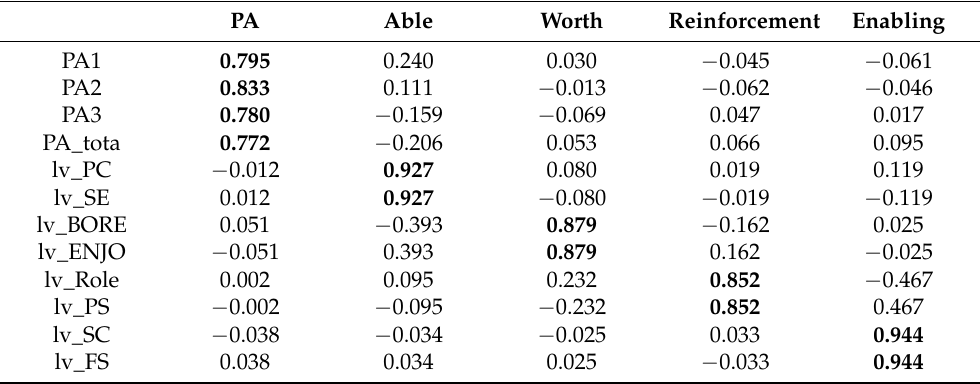
Table A1. Combined loadings and cross-loadings of the variables involved in the second-order measurement model. PA Able